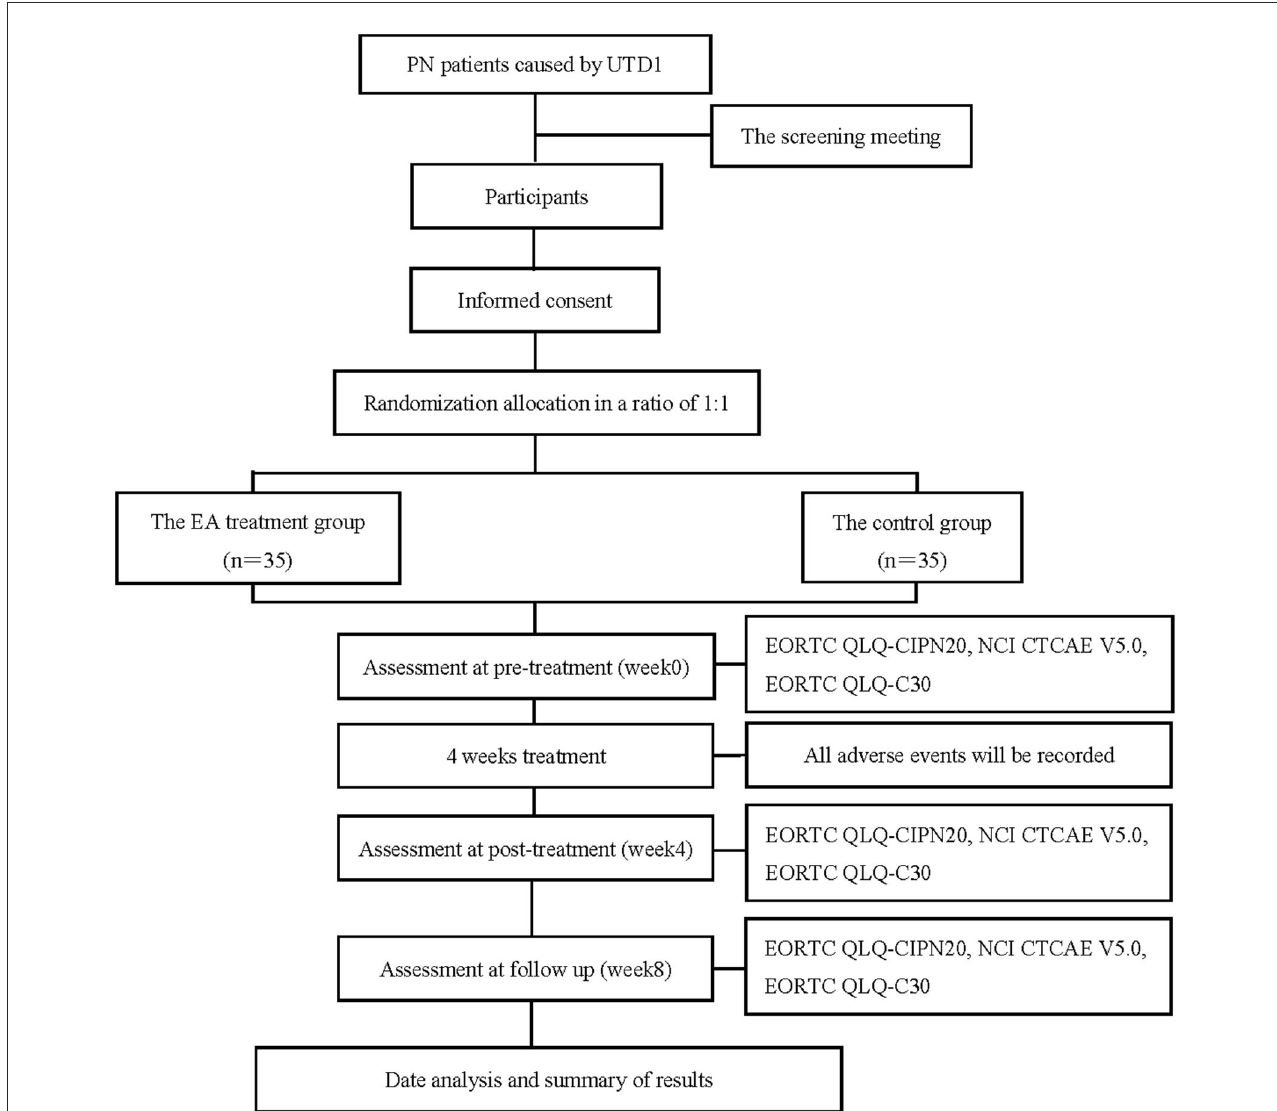
FIGURE1 Flow chart of the study process. PN, peripheral neuropathy; UTD1, Utidelone; EA, Electroacupuncture; EORTC QLQ-CIPN20, the European Organization for Research and Treatment of Cancer, Quality of Life Questionnaire-chemotherapy-induced peripheral neuropathy 20; NCI CTCAE V5.0, National Cancer Institute Common Terminology Criteria for Adverse Events Version 5.0; EORTC QLQ-C30, the European Organization for Research and Treatment of Cancer, Quality of Life Questionnaire-Core